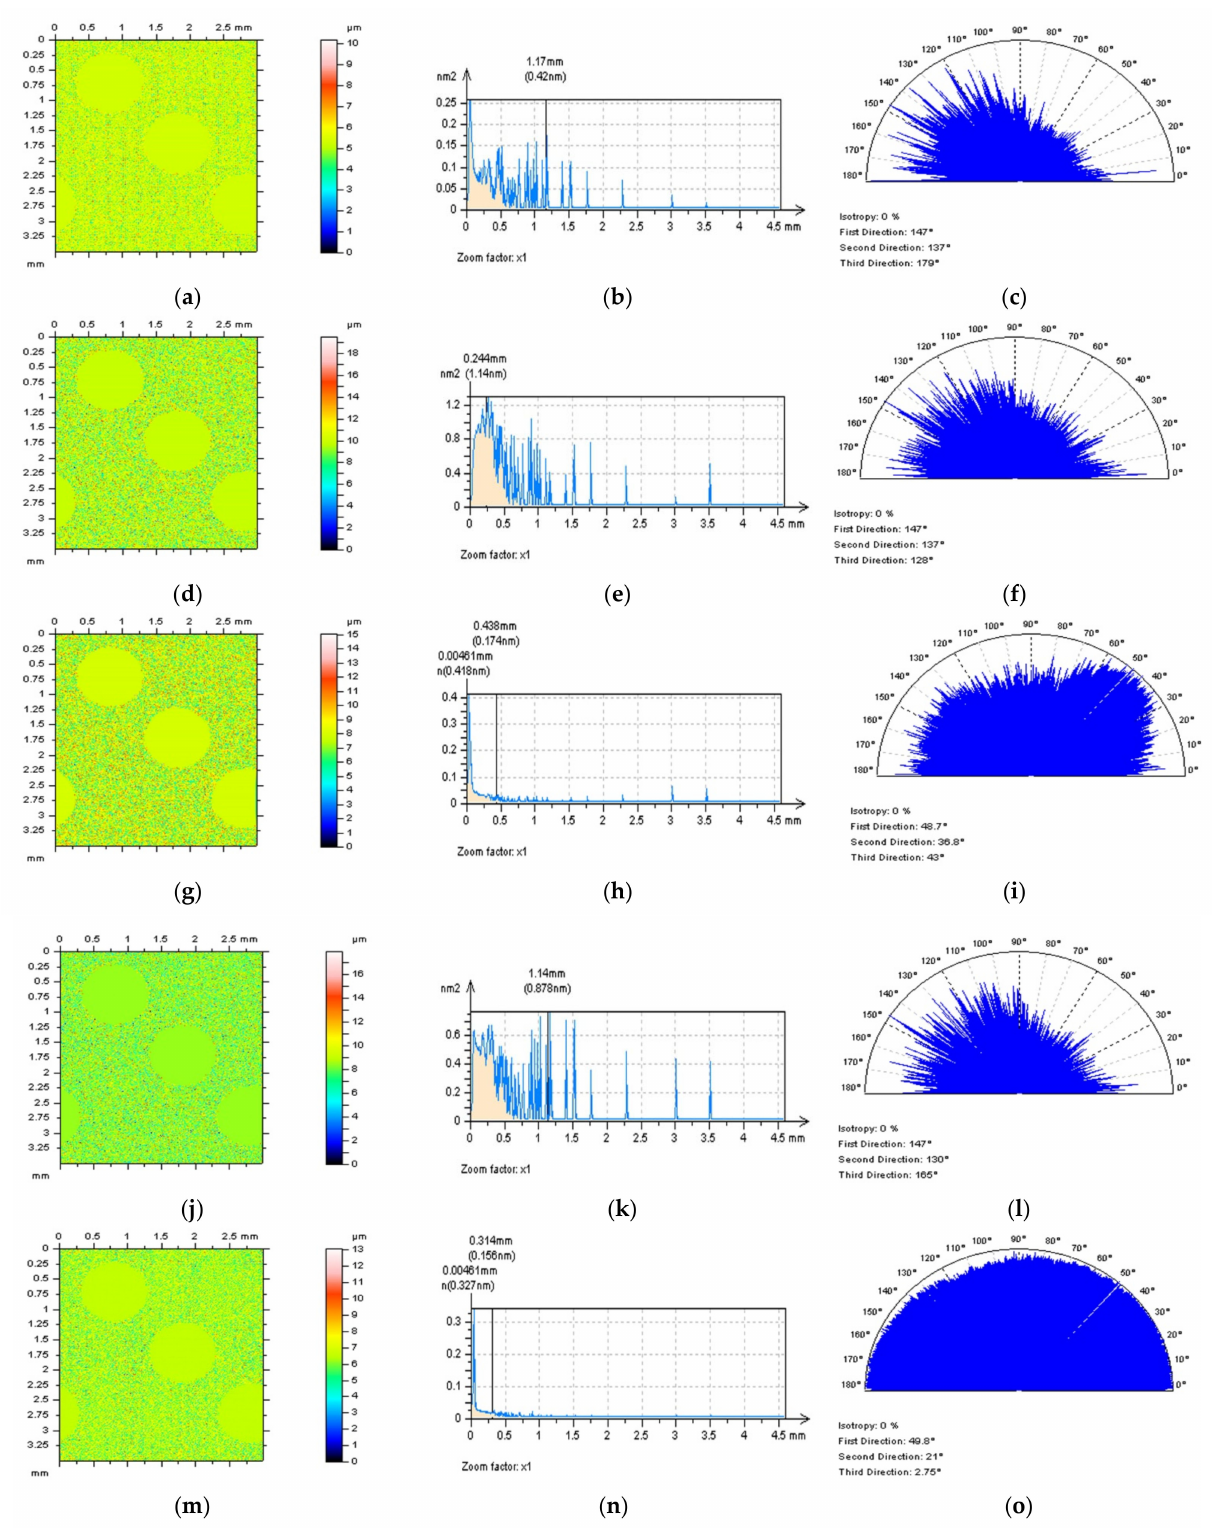
Figure 7. Isometric views of the S-surfaces (left column), their PSDs (middle), and TD graphs (right column) received after the application of GRF ( a – c ), RGRF ( d – f ), SF ( g – i ), MDF ( j – l ), and FFTF ( m – o ) method with a cutoff = 0.025